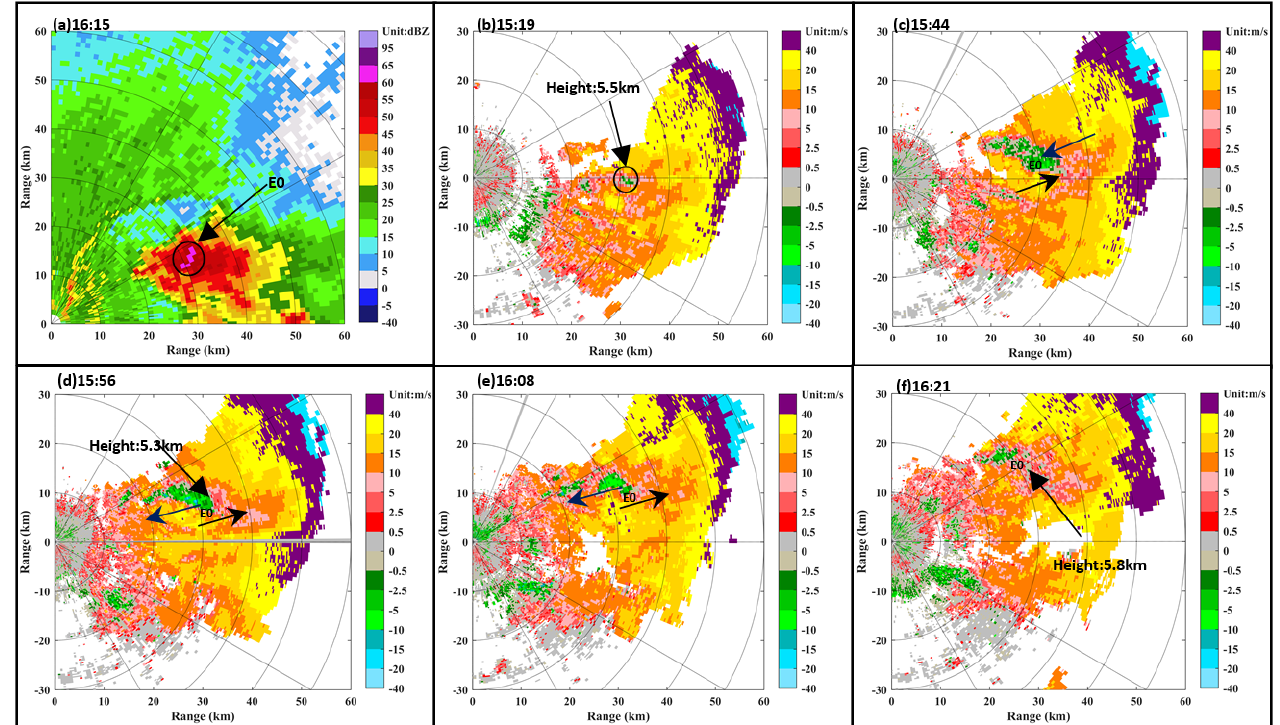
Figure 9 Figure 9. Radar echoes from Jinan, Shandong on 25 July 2006. ( a ) 16:15 is the reflectivity PPI at